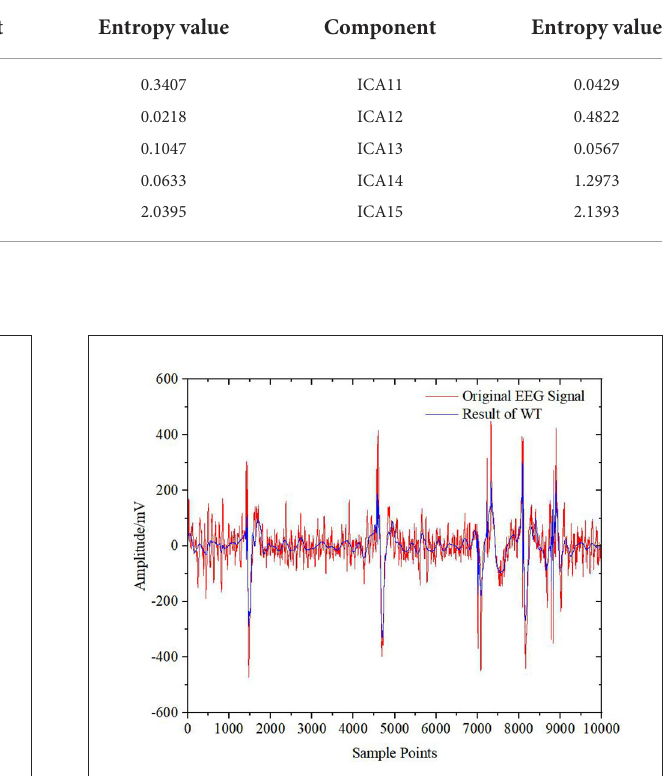
FIGURE9 D5 signal and clean D5 signal.